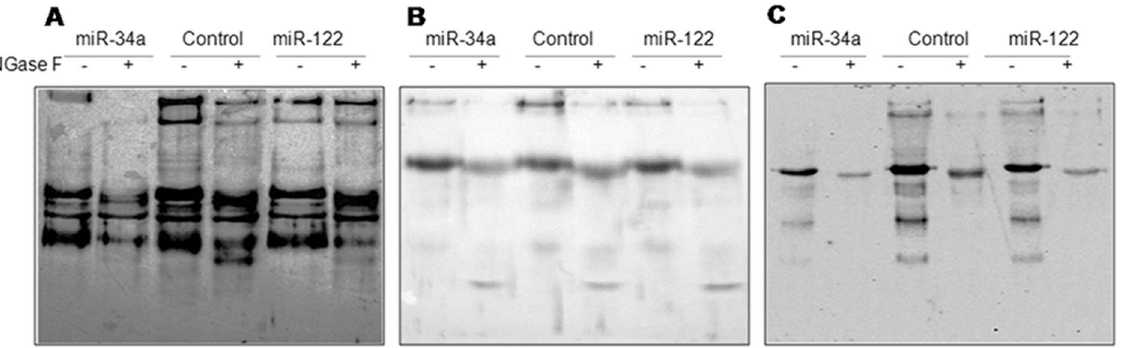
Figure 4. Lectin blot analysis of culture media from HepG2, Hepa1C1C7 and HTC cells after miRNA mimic transfection. Secreted proteins recovered from cell culture supernatants were run on a 10% SDS-PAGE gel and proteins were then blotted on a PVDF membrane. The membrane was probed with biotinylated-LCA and revealed with streptavidin-HRP. Parallel samples were also extensively treated with PNGase F in order to remove N-linked glycans and ensure the specificity of the signal. Representative experiments are